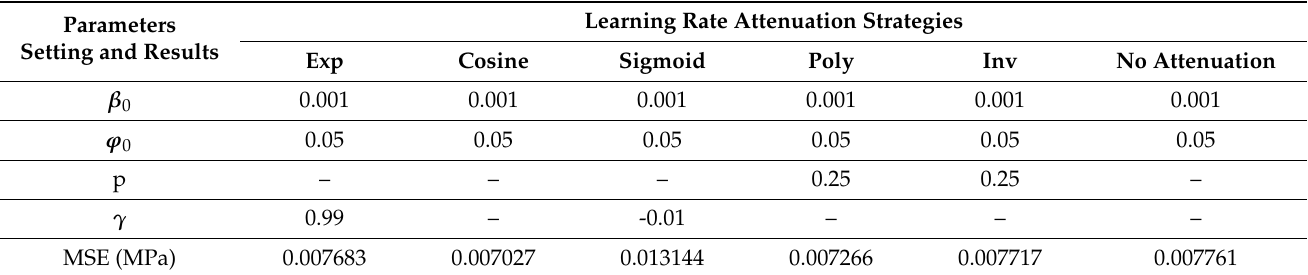
Figure 10. Mean square error of learning rate attenuation strategies in oil pressure recognition. Table 2. Parameters setting and results analysis of learning rate attenuation strategies.